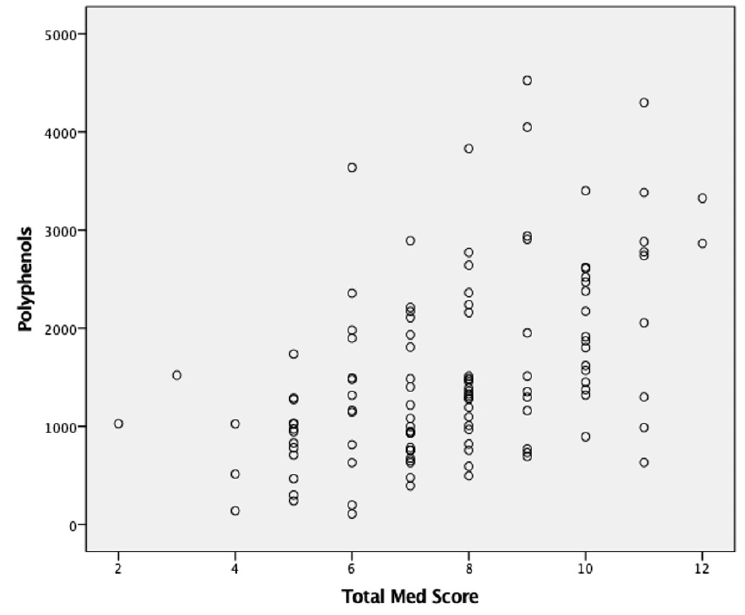
Figure 1. Scatter plot between total polyphenol intake (mg epicatechin equivalents/100 g food) and total Med Score [obtained from Mediterranean Diet Adherence Score (MEDAS)].